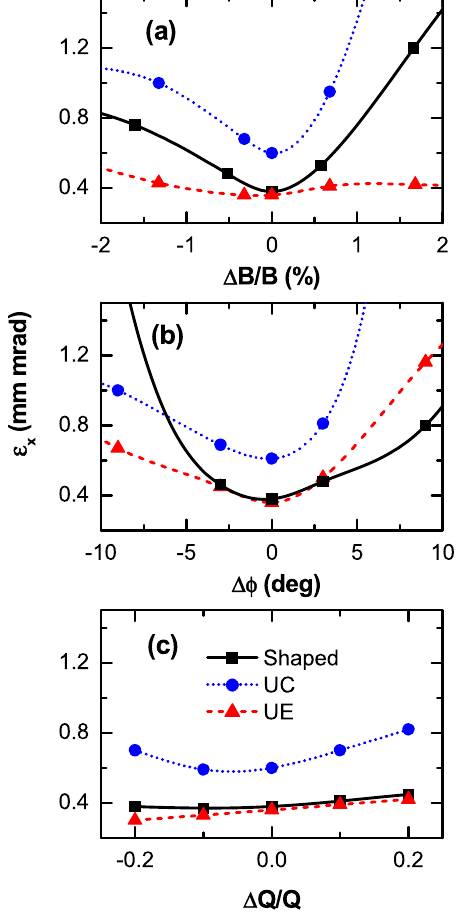
FIG. 6. (Color) Beam emittance at the end of the booster linac as a function of (a) solenoid field error, (b) the launch phase error, and (c) the charge fluctuation. Thermal emittance is not included